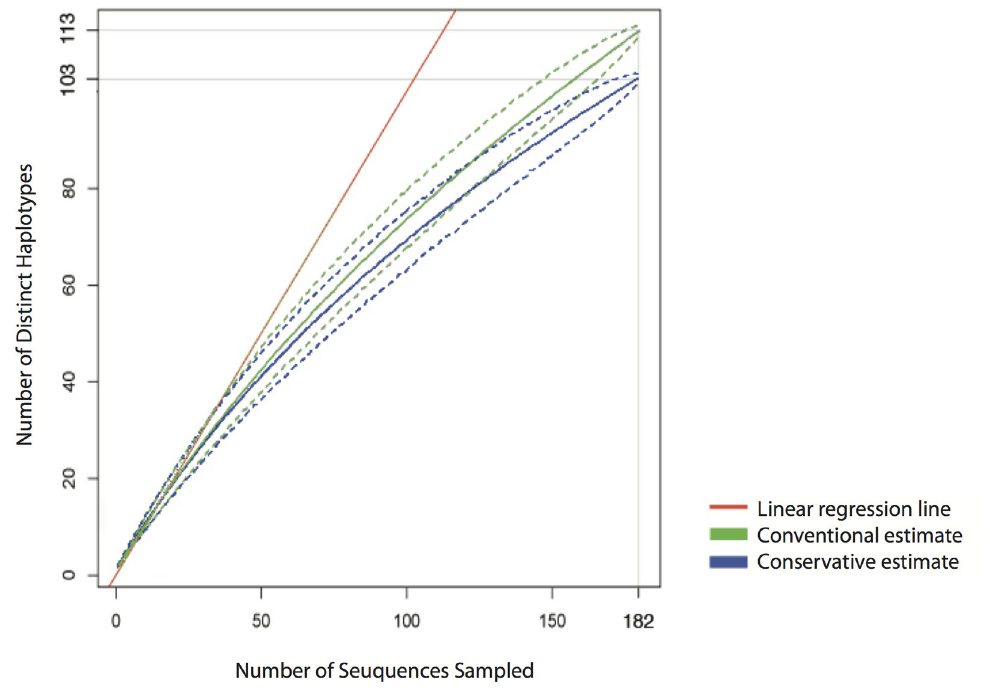
Figure 3. Monte Carlo simulations showing distinct variant numbers of PLS sequences, for both conventional (every new SNP leads to a different allele) and conservative (alleles are only counted if SNPs occurs more than once) estimates (1000 replicates). Dashed lines show 95% confidence intervals of the mean of the simulated values. doi: